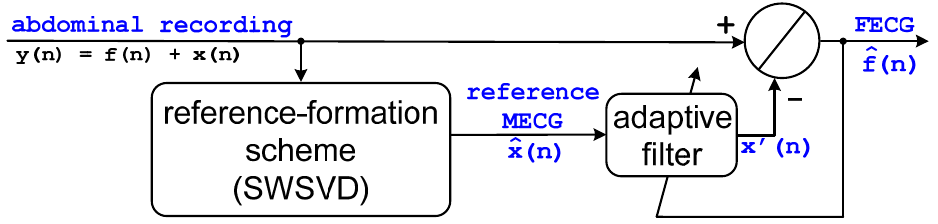
Figure 1. A block diagram of the proposed structure y ( n ) : abdominal recording (AECG), f ( n ): FECG in AECG, x ( n ): MECG in AECG, ˆ x ( n ) : reference MECG estimated by reference formation scheme (SWSVD), ˆ f ( n : extracted